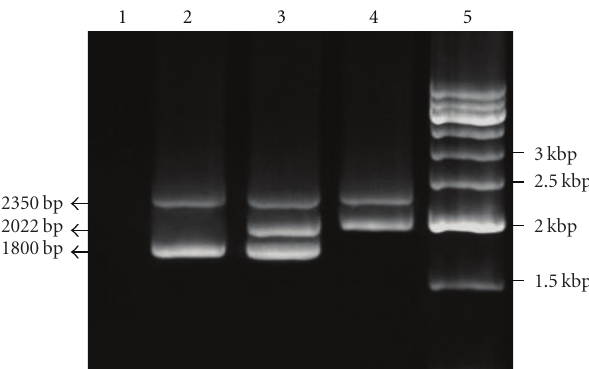
Figure 2: Detection of alpha-thalassemia on agarose gel after multiplex PCR. Lane 1: DNA blank; lane 2: normal controls ( αα/αα ) with a 2350 bp LIS 1 internal control band and a 1800bp α 2-globin gene band; lane 3: single α -globin gene deletion carrier ( − α 3 . 7 /αα ) with an internal control band, a 2022 bp deletion-specific band and an α 2-globin gene band; lane 4: individual homozygous for α - globin gene deletion ( − α 3 . 7 / − α 3 . 7 ) with an internal control band and a 2022 bp deletion-specific band; lane 5 :500 bp molecular weight